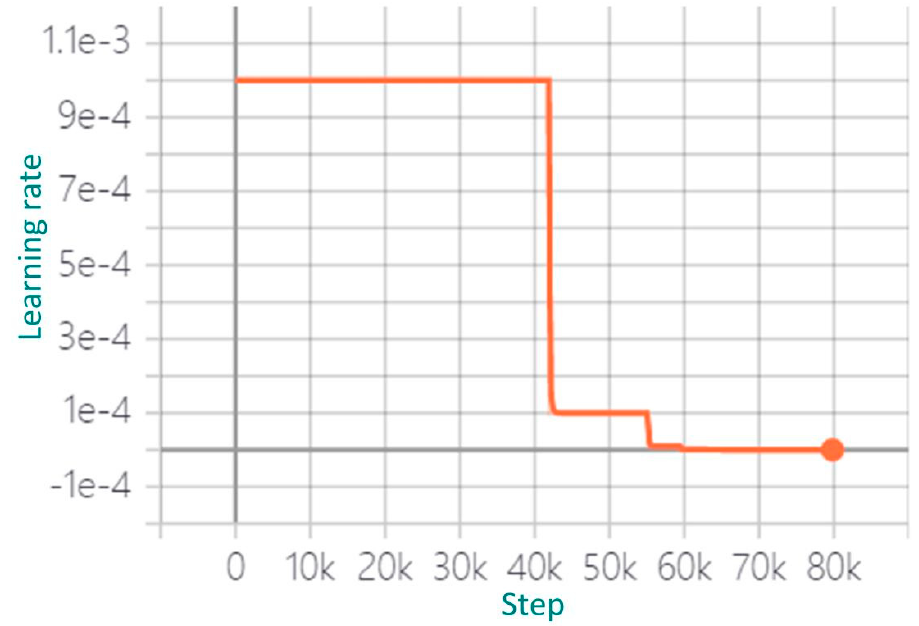
Figure 4. Variation of learning rate parameters.